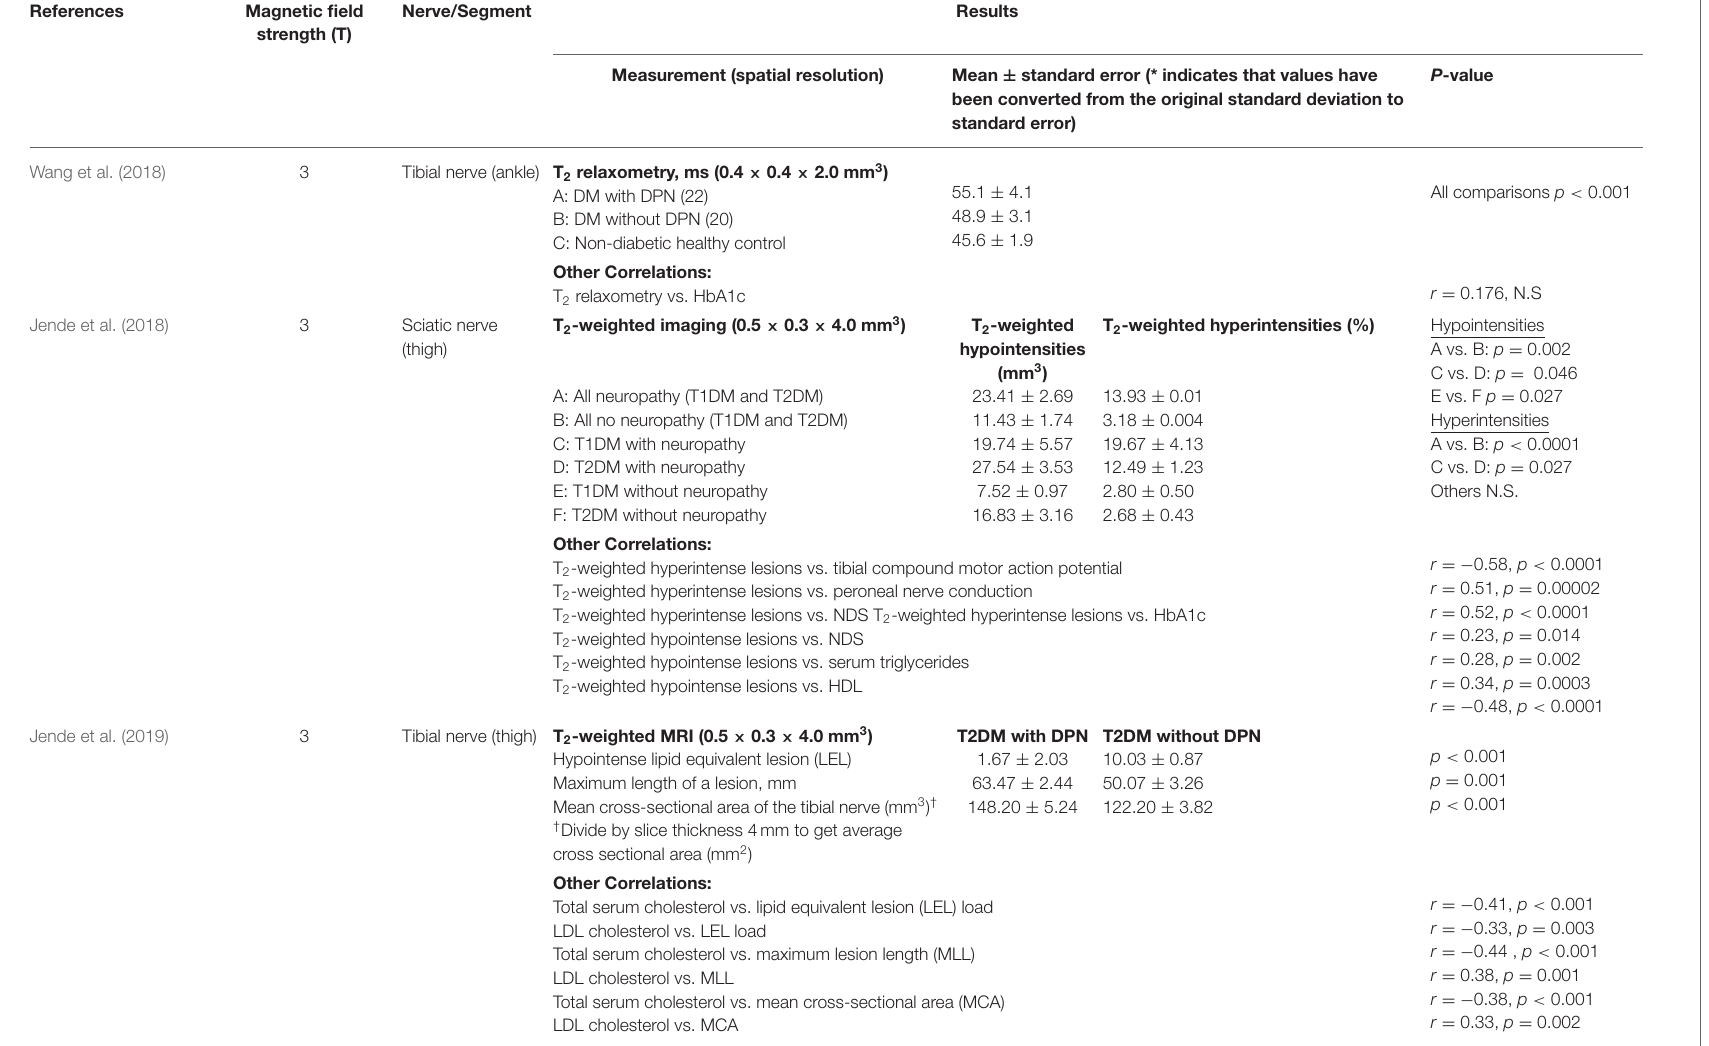
Other Correlations: Total serum cholesterol vs. lipid equivalent lesion (LEL) load LDL cholesterol vs. LEL load Total serum cholesterol vs. maximum lesion length (MLL) LDL cholesterol vs. MLL Total serum cholesterol vs. mean cross-sectional area (MCA) LDL cholesterol vs.